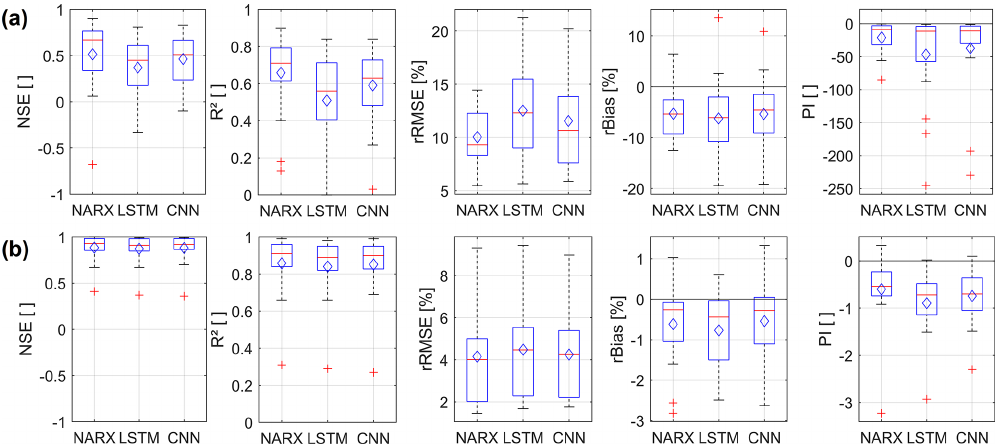
Figure 4. Boxplots showing the seq2val forecast accuracy of NARX, LSTM, and CNN models within the test period (2012–2016) for all considered 17 hydrographs. The diamond symbols indicate the arithmetic mean; (a) only meteorological inputs; (b) GWL t − 1 as additional